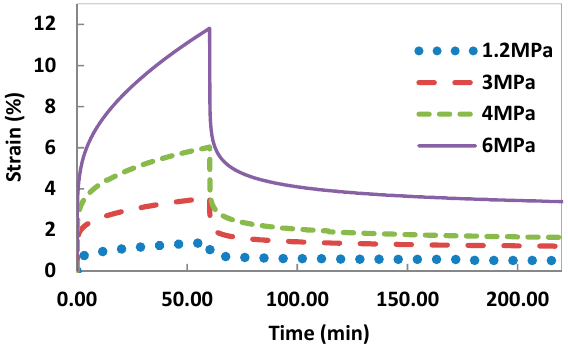
Figure 1. Creep-recovery response of composite material (PB1) at different initial stresses.